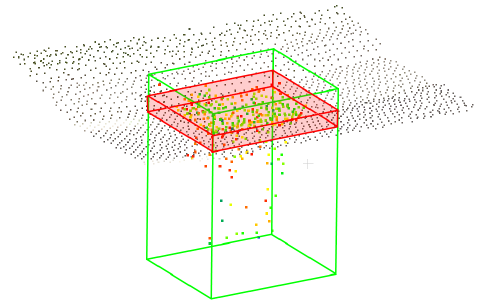
Figure 4. Example of the clustering results of the hardscape class. Green clusters contain a storm drain while other hard scape objects are shown by the red bounding